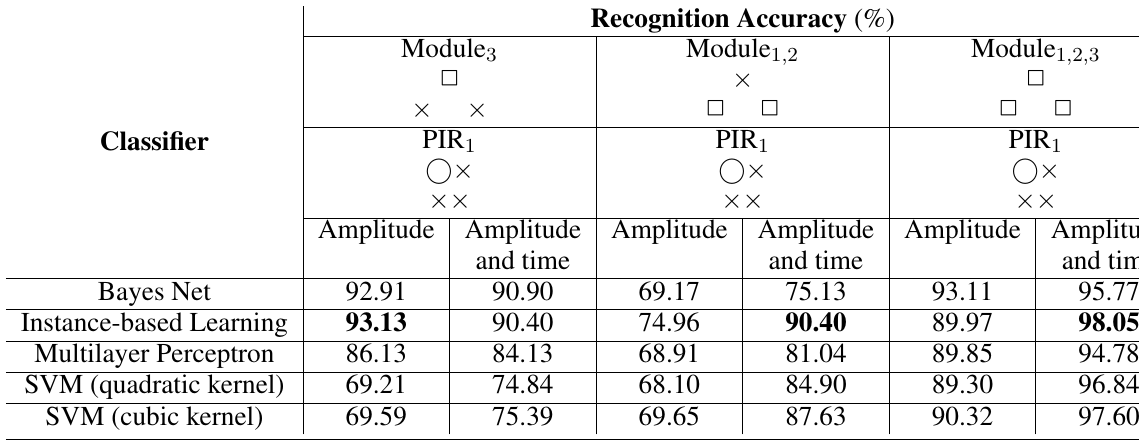
Table 10. Comparison of the recognition accuracy (%) of classifying walking distance intervals based on the reduced feature set with respect to the modules and features (amplitude and time to peaks).